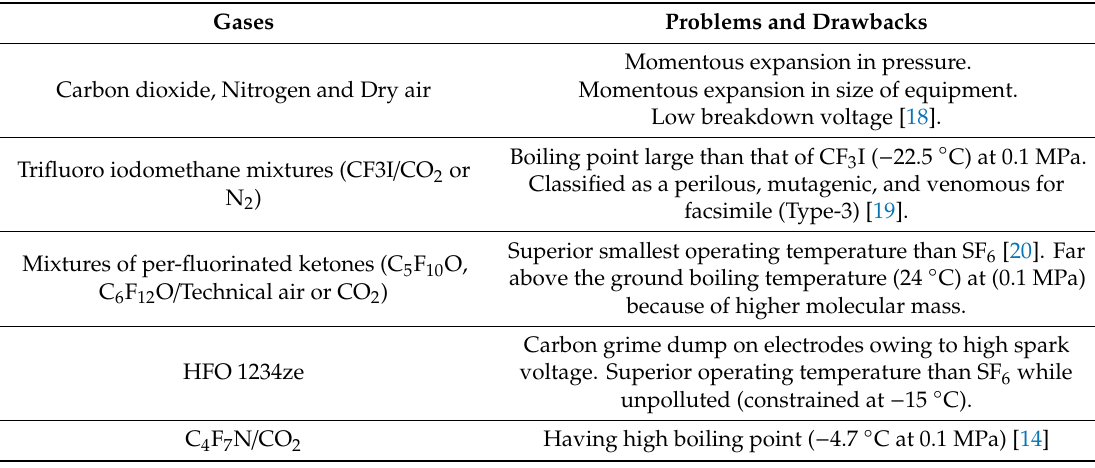
Table 1. Association of SF 6 replacement.